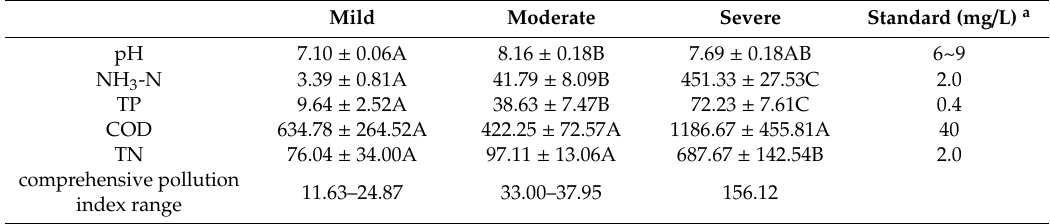
Table 2. Environmental variables of water samples with di ff erent pollutant